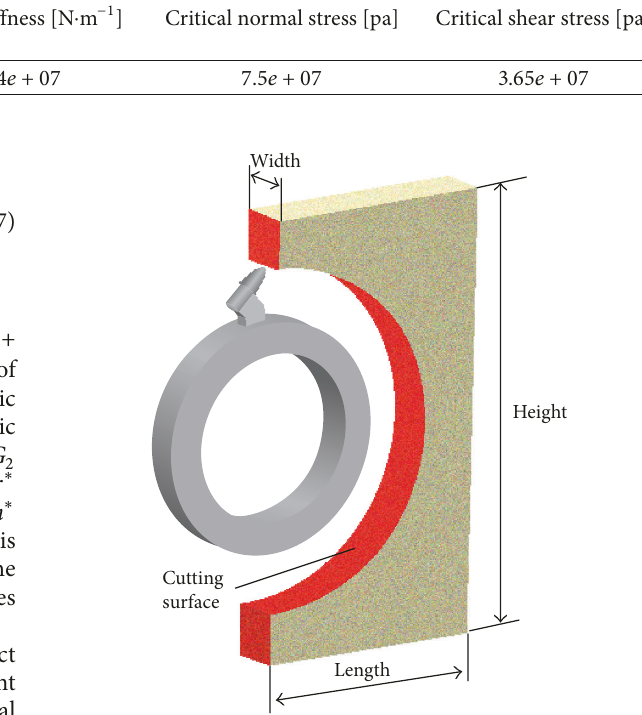
Figure 3: EDEM model of coal cutting process of conical